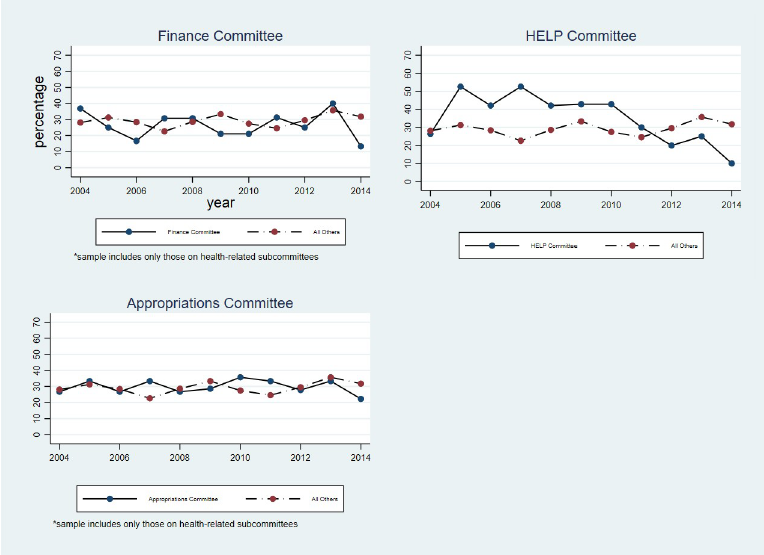
Fig 5. Share of members holding health care-related assets: Senate committees. � Finance and Appropriations Committee samples include only those on health-related